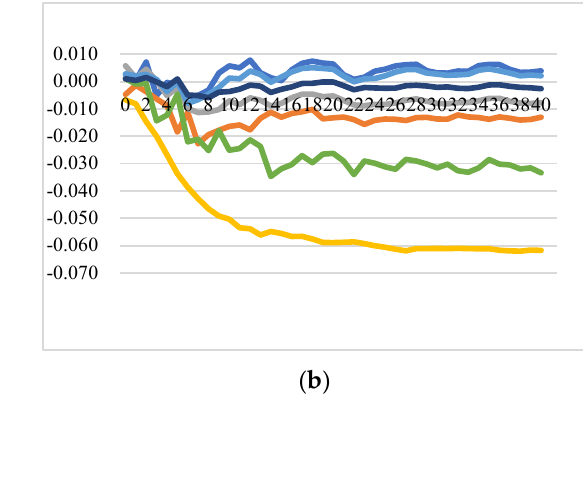
Figure 10. Generalized impulse response functions (GIRFs) of six EU member states’ extra-EU cheese export prices after a positive one-standard-error shock to raw milk price (bootstrap median estimates). ( a ) GIRFs after a shock to France’s raw milk price. ( b ) GIRFs after a shock to Germany’s raw milk price. ( c ) GIRFs after a shock to Ireland’s raw milk price. ( d ) GIRFs after a shock to Italy’s raw milk price. ( e ) GIRFs after a shock to the Netherlands’ raw milk price. ( f ) GIRFs after a shock to the UK’s raw milk price. ( g ) GIRFs after a shock to the rest of the EU’s raw milk price. ( h ) legend.